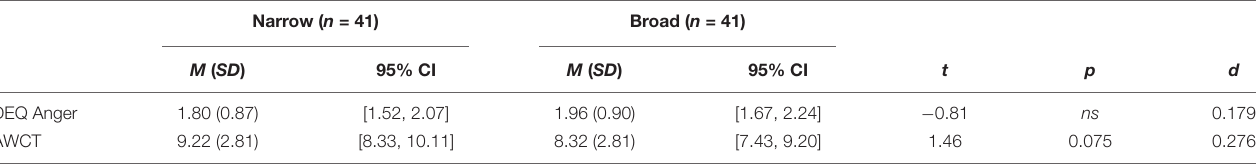
TABLE 7 | Effect of cognitive scope condition on state anger and angry word accessibility – Study 7.